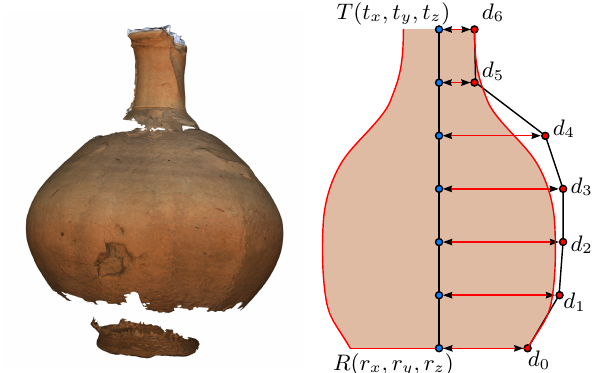
Figure 4: The vase on the left hand side is a digitized artifact of the “Museum Eggenberg” collection. It consists of 364774 ver- tices and 727898 triangles. The example of a procedural shape on the right hand side takes two points R and T in 3D and dis- tance values, which define the control vertices of a B´ezier